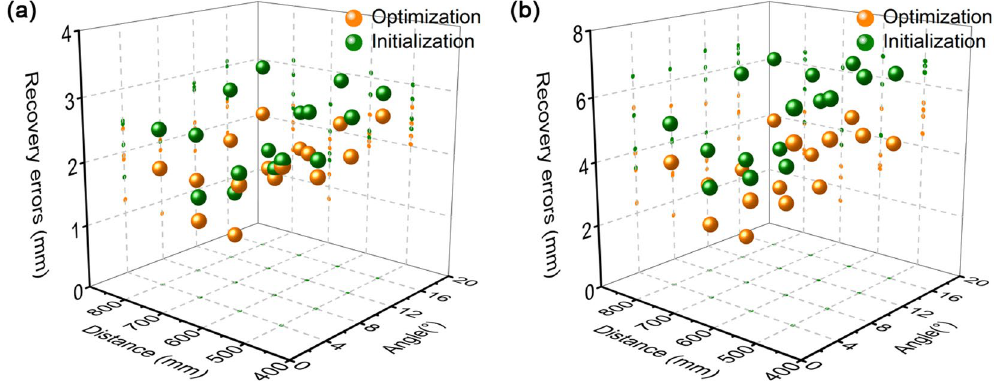
Figure 7. The statistical means and maximums of the recovery errors under the measurement distances of 500 mm, 600 mm, 700 mm, 800 mm, and the relative angles of 4°, 8°, 10°, 12°. ( a ) The statistical means of the optimization method and initialization method. ( b ) The statistical maximums of the optimization method and initialization